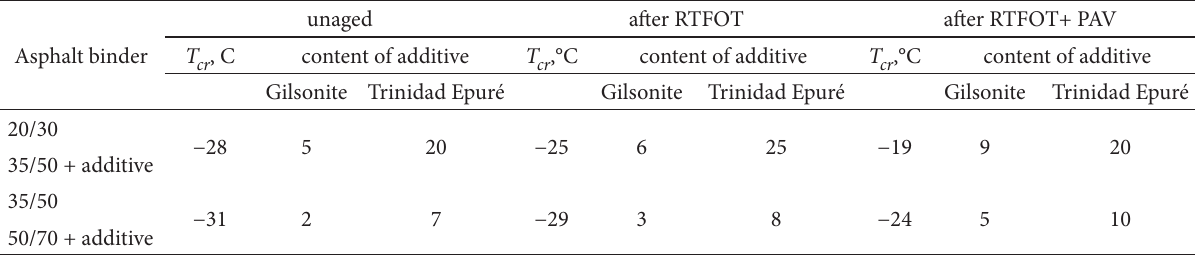
Table 10. The average critical temperature of the unmodified and modifies asphalt binders along with an equivalent content of modifier unaged after RTFOT after RTFOT+ Asphalt binder